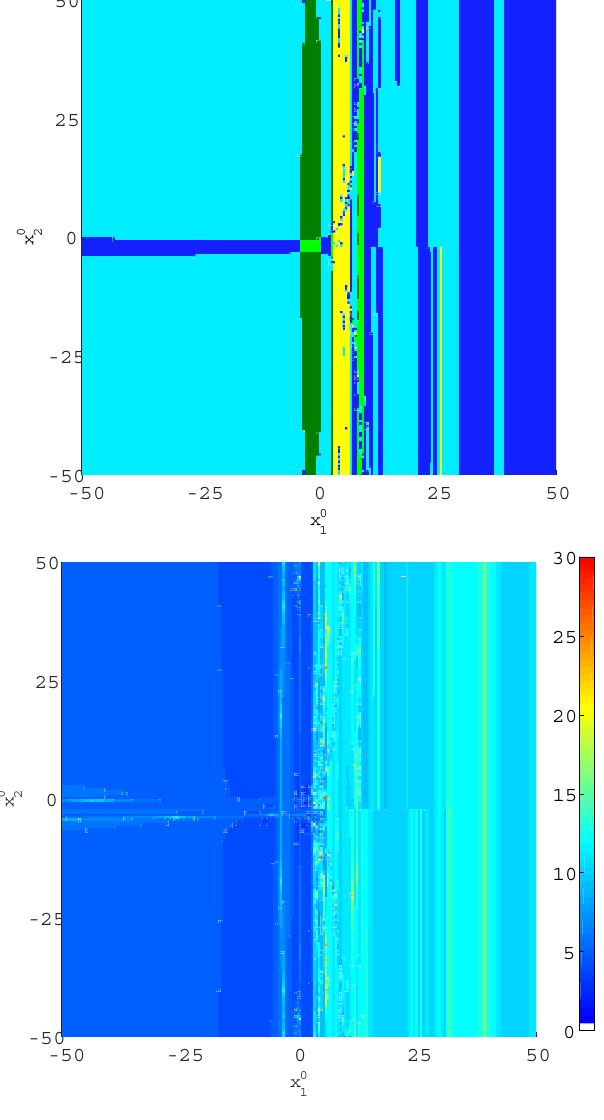
Figure 8. Basins of attraction ( upper ) and number of iterations ( lower ) for Kelley’s system when the factored method with m = 2 + 0.5 i is